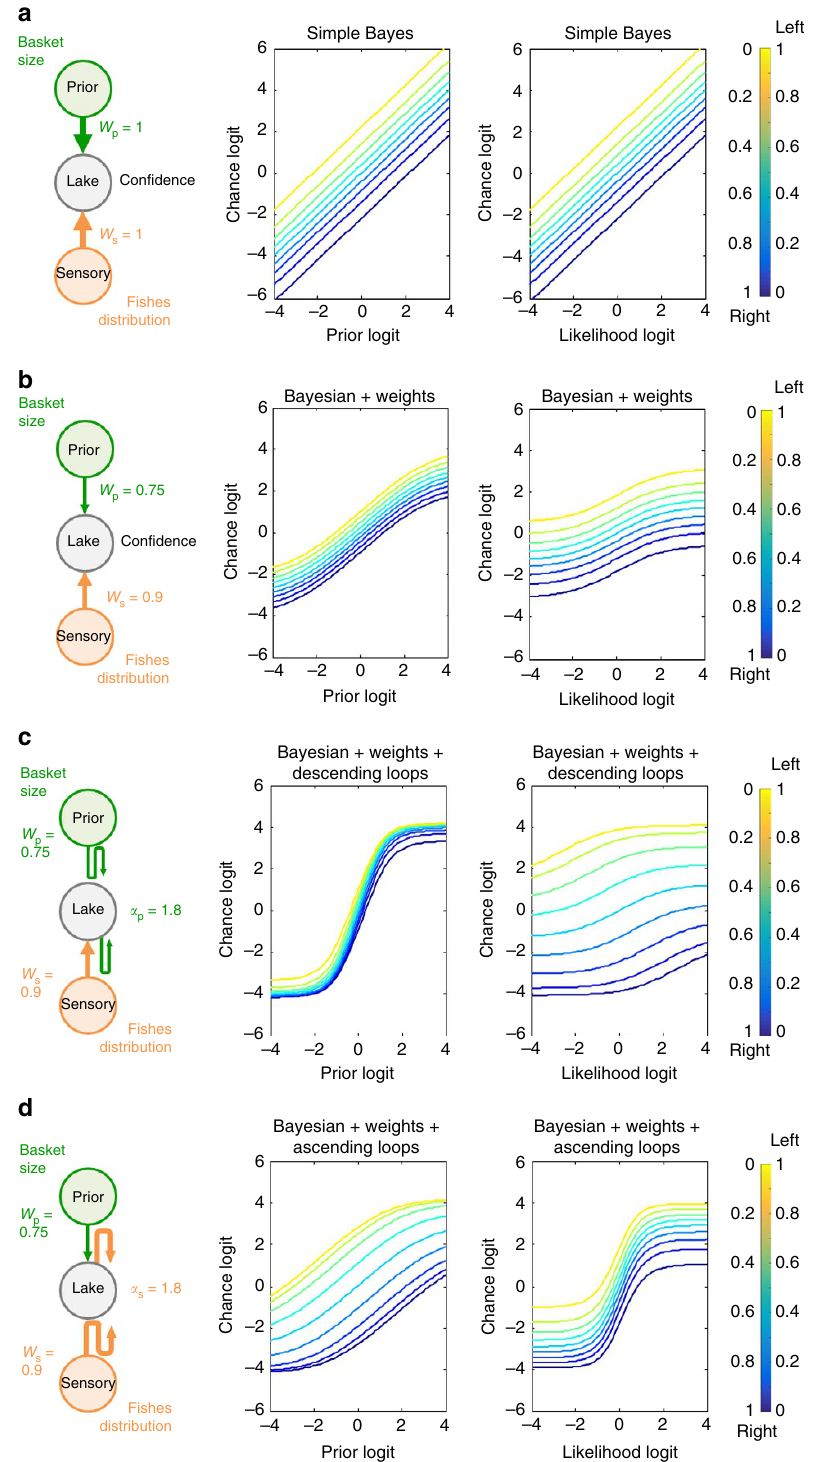
Figure 2 | Model predictions. The predictions of each model are plotted as the chance logit against the prior logit and against the likelihood logit (middle and right panels, respectively). In the plots, the likelihood and prior information is colour-coded (from dark blue to yellow) according to the true probability that the fish originated from one of the two lakes in the Fisher task. The simple Bayes model is presented in a , with the strength of the prior and the value of the likelihood equal to 1 ( w p ¼ 1; w s ¼ 1). The first variant of the model (that is, the weighted model) is presented in b , in which the strength of the messages was manipulated ( w p ¼ 0.75; w s ¼ 0.9, arrow size in the graph model). This model enables the modulation of the chance/prior/likelihood relationship. The circular inference model is implemented in c , d . The addition of inhibitory factors at each level of the hierarchy enables the flow of information to be controlled. This inhibitory control can act independently for feed-forward and feedback propagation. Predictions for large levels of descending loops ( a p ¼ 1.8) are presented in c whereas predictions for large levels of ascending loops ( a s ¼ 1.8) are presented in d